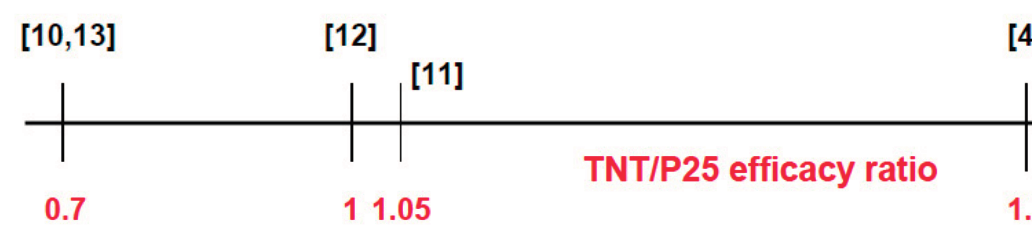
Figure 4. TNT/P25 TNP efficacy ratio in the photocatalytic removal of toluene [4,10,11] or acetaldehyde [12,13]. The corresponding references are indicated in brackets.